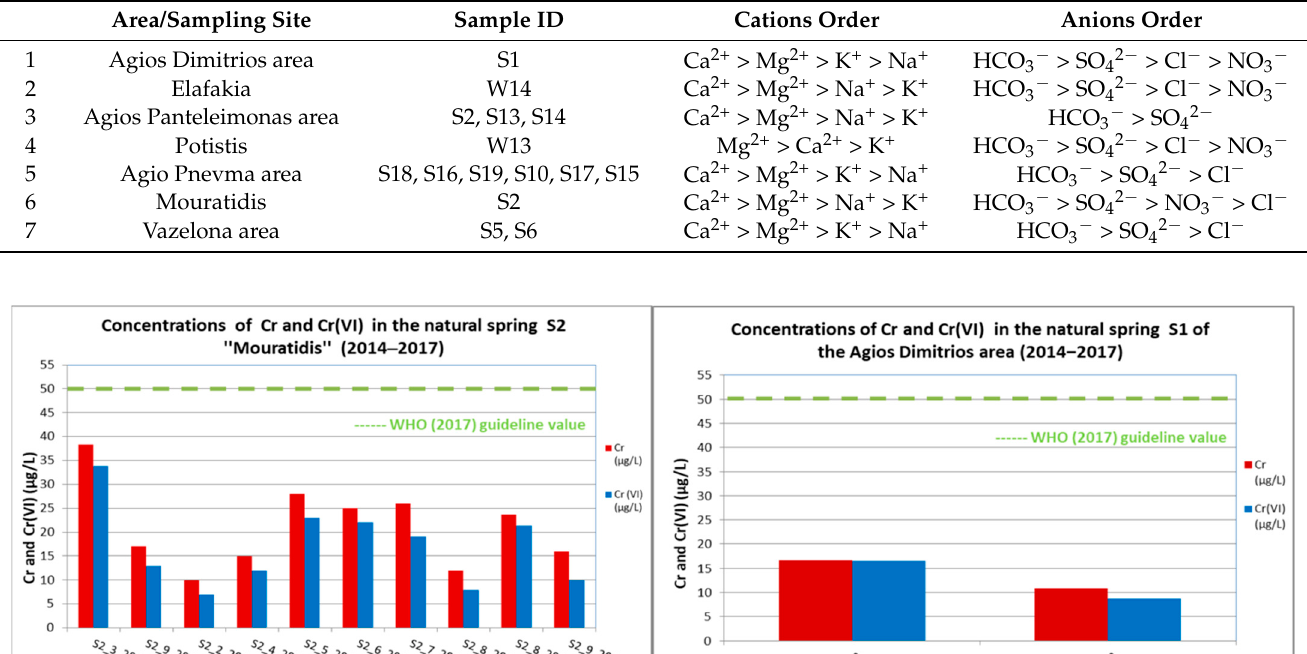
Table 4. The abundance of major ions among the natural springs in western Vermio Mt.